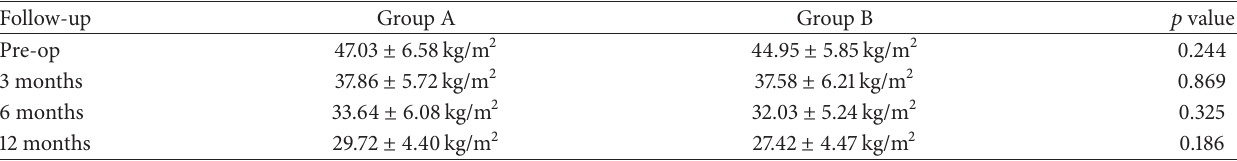
Table 3: Mean BMI in the